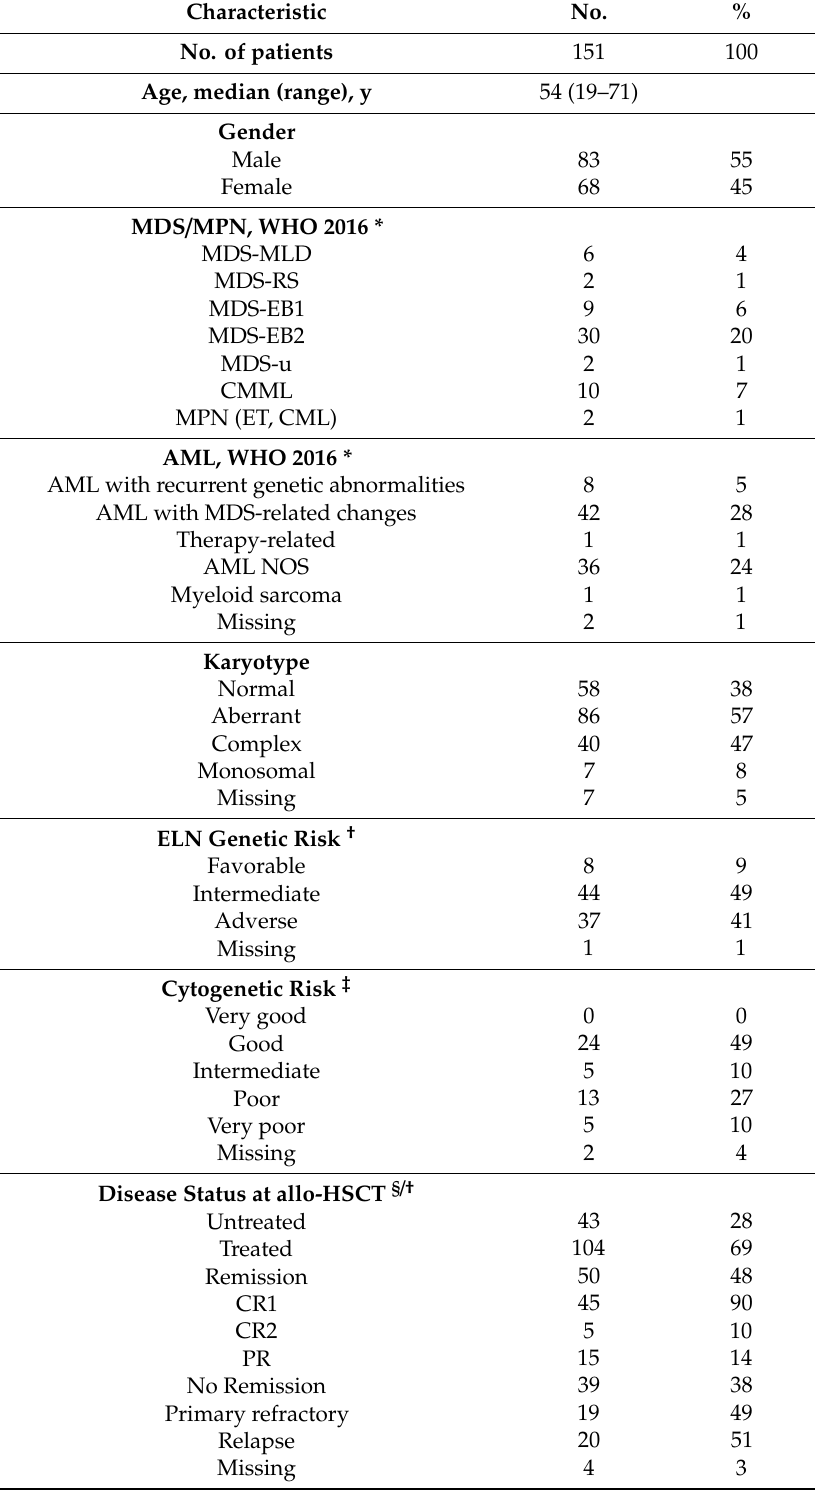
Table 1. Patients demographics and clinical